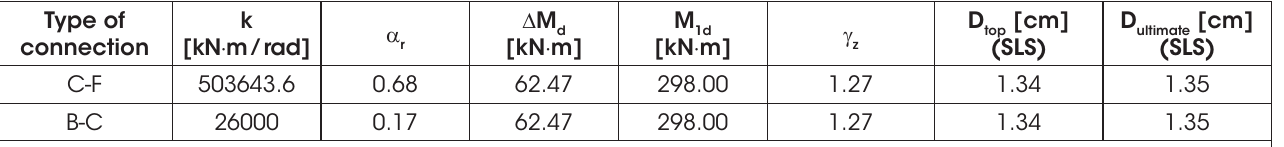
Verification of the modified optimal model Type